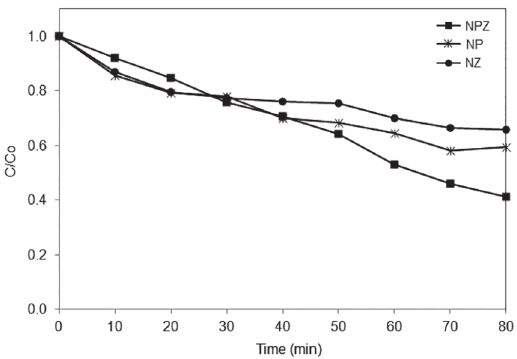
Figure 3: TEM images of the TiO sample) at 2.500.000x magnification.